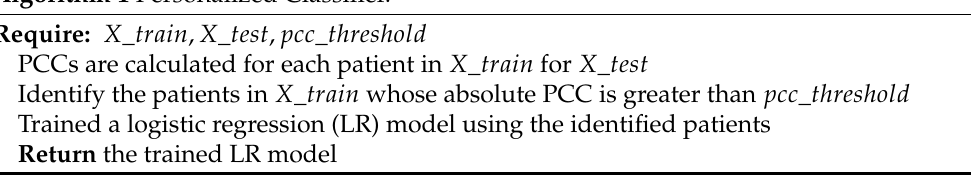
Algorithm 1 Personalized